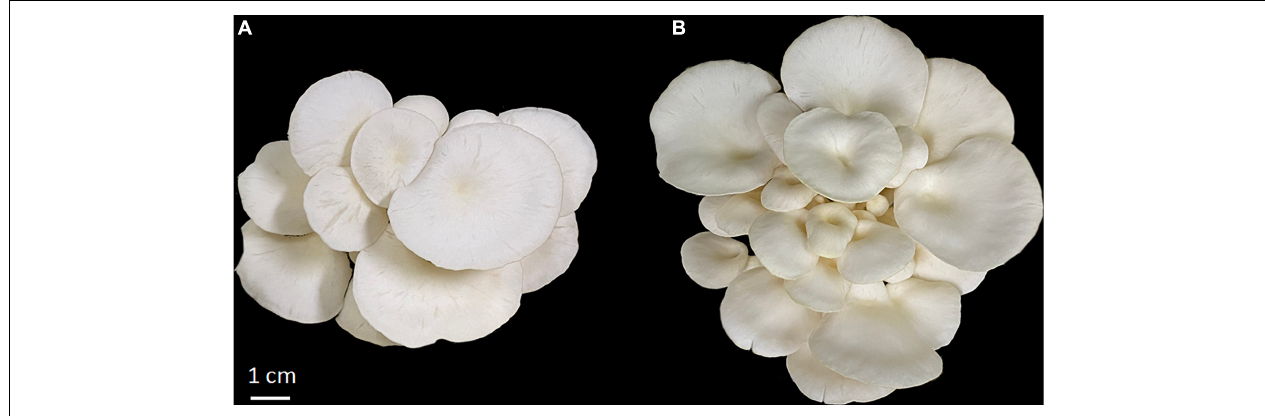
FIGURE 1 | The fruiting body of P. ostreatus var. florida used in this study. (A) Sample from control group; (B) sample from AMM